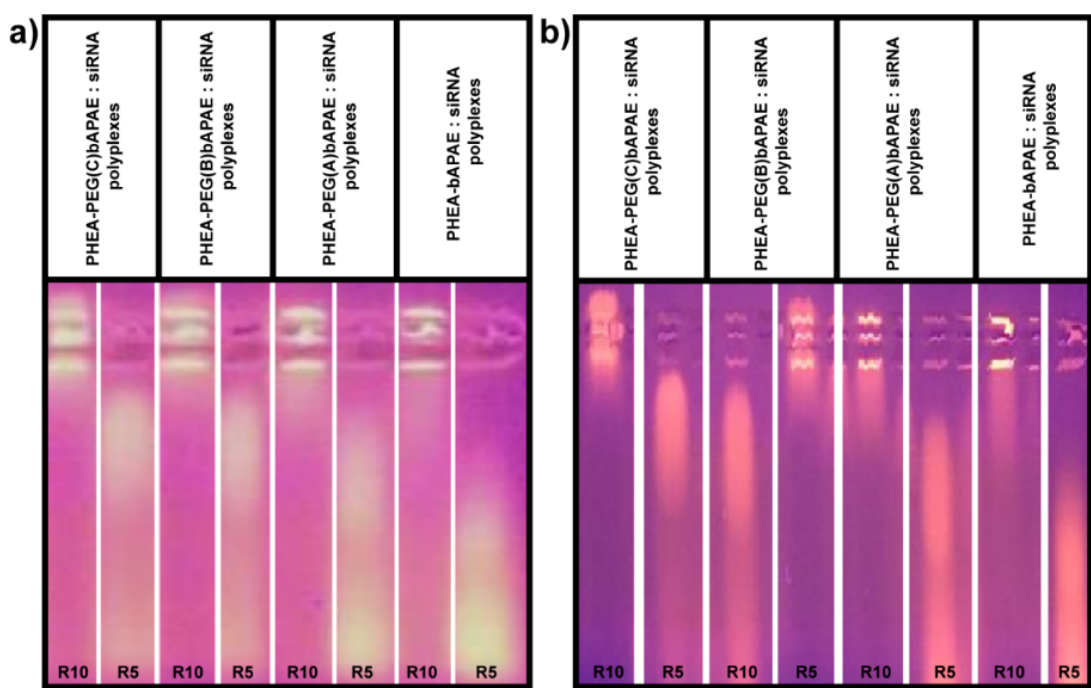
Figure 12. Gel electrophoresis in the presence of mucin, after ( a ) 2 h and ( b ) 5 h of incubation, at R = 5 and 10.